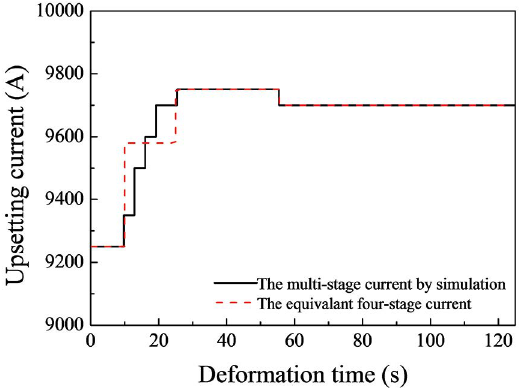
Figure 15: Simulated and equivalent multi-stage upsetting current.